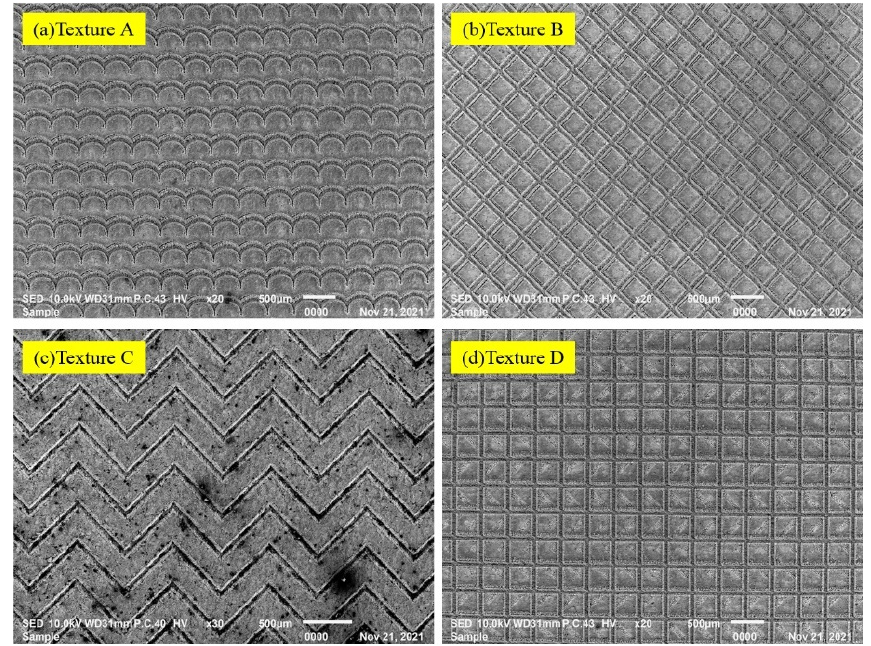
Figure 2. SEM morphology of laser ablation textures ( a ) texture A, ( b ) texture B, ( c ) texture C and ( d ) texture D.